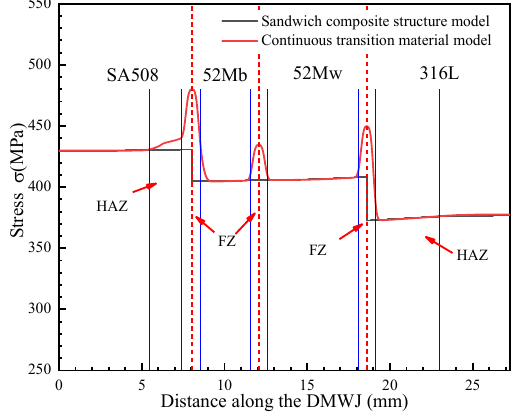
Figure 13. Stress along the DMWJ under an axial load and internal pipe pressure. 0 Distance along the DMWJ (mm) Sandwich composite structure model Continuous transition material model SA508 FZ Figure 14. PEEQ along the DMWJ under an axial load.